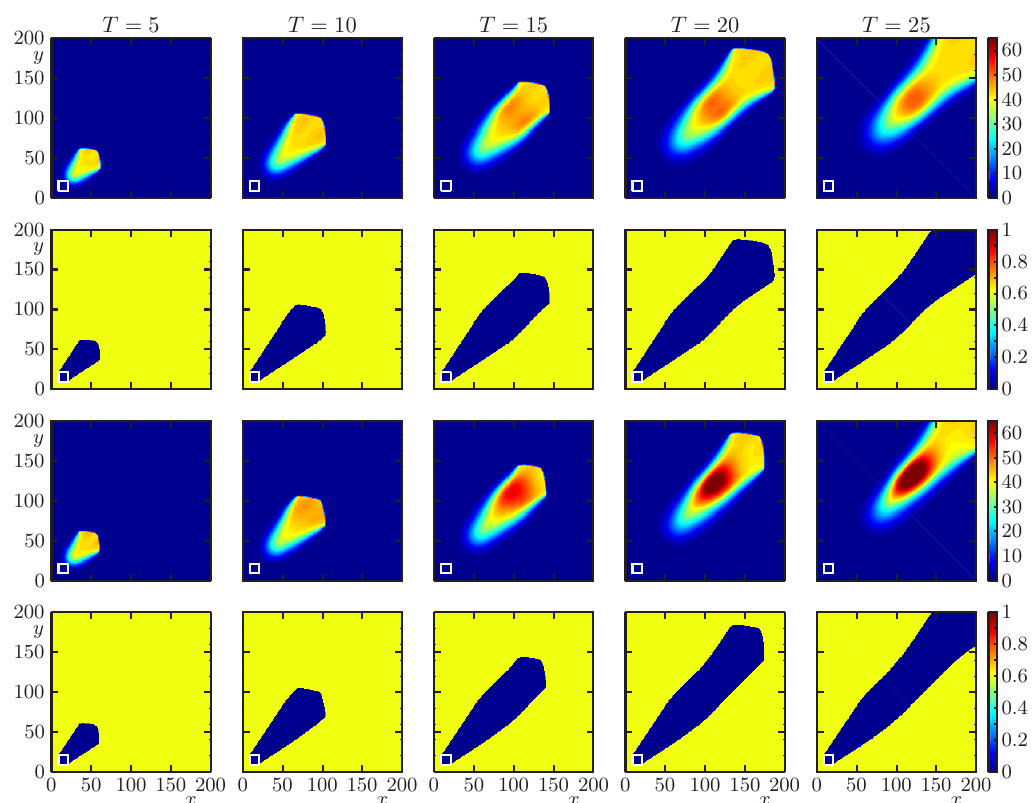
Figure 6. Scenarios 2.3 and 2.4: simulation of the propagation of a forest fire on domains with topographies (first and second row) and (third and fourth T 2 T 3